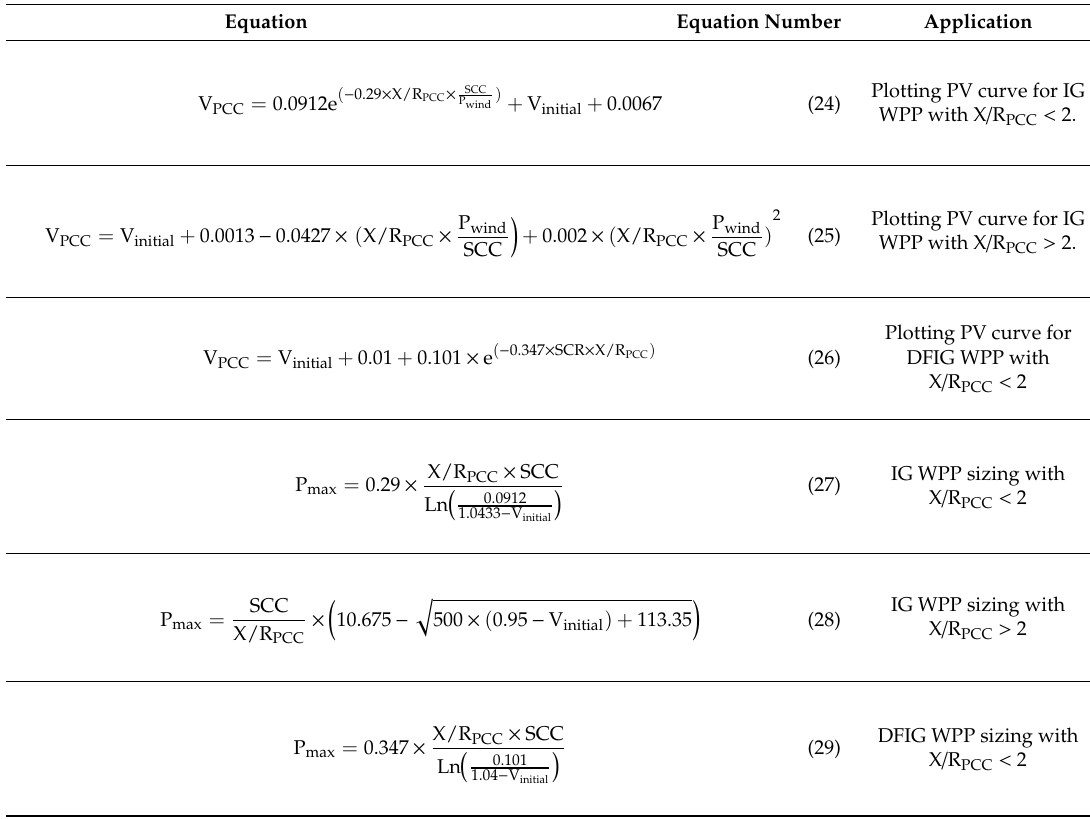
Table 10. Proposed mathematical model.